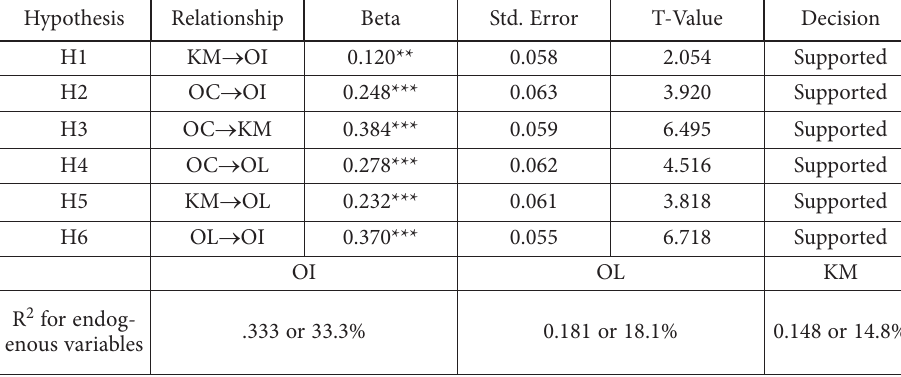
Table 6. Testing results of direct hypotheses